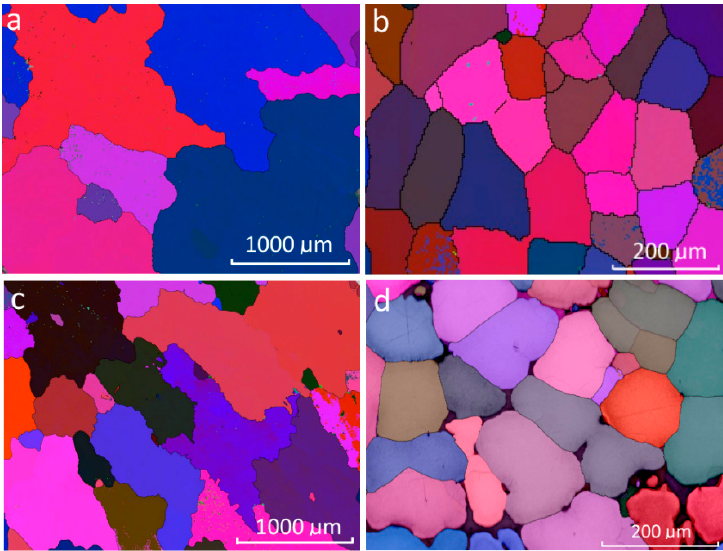
Figure 4. Microstructures of ( a ) Al–5Mg; ( b ) Al–5Mg w/UST; ( c ) Al–10Mg; ( d ) Al–10Mg